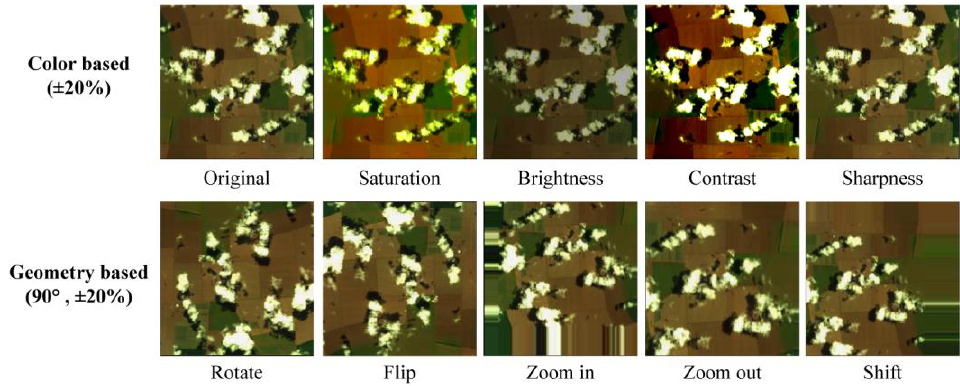
Figure 8. Data augmentation-based color and geometry transformation.